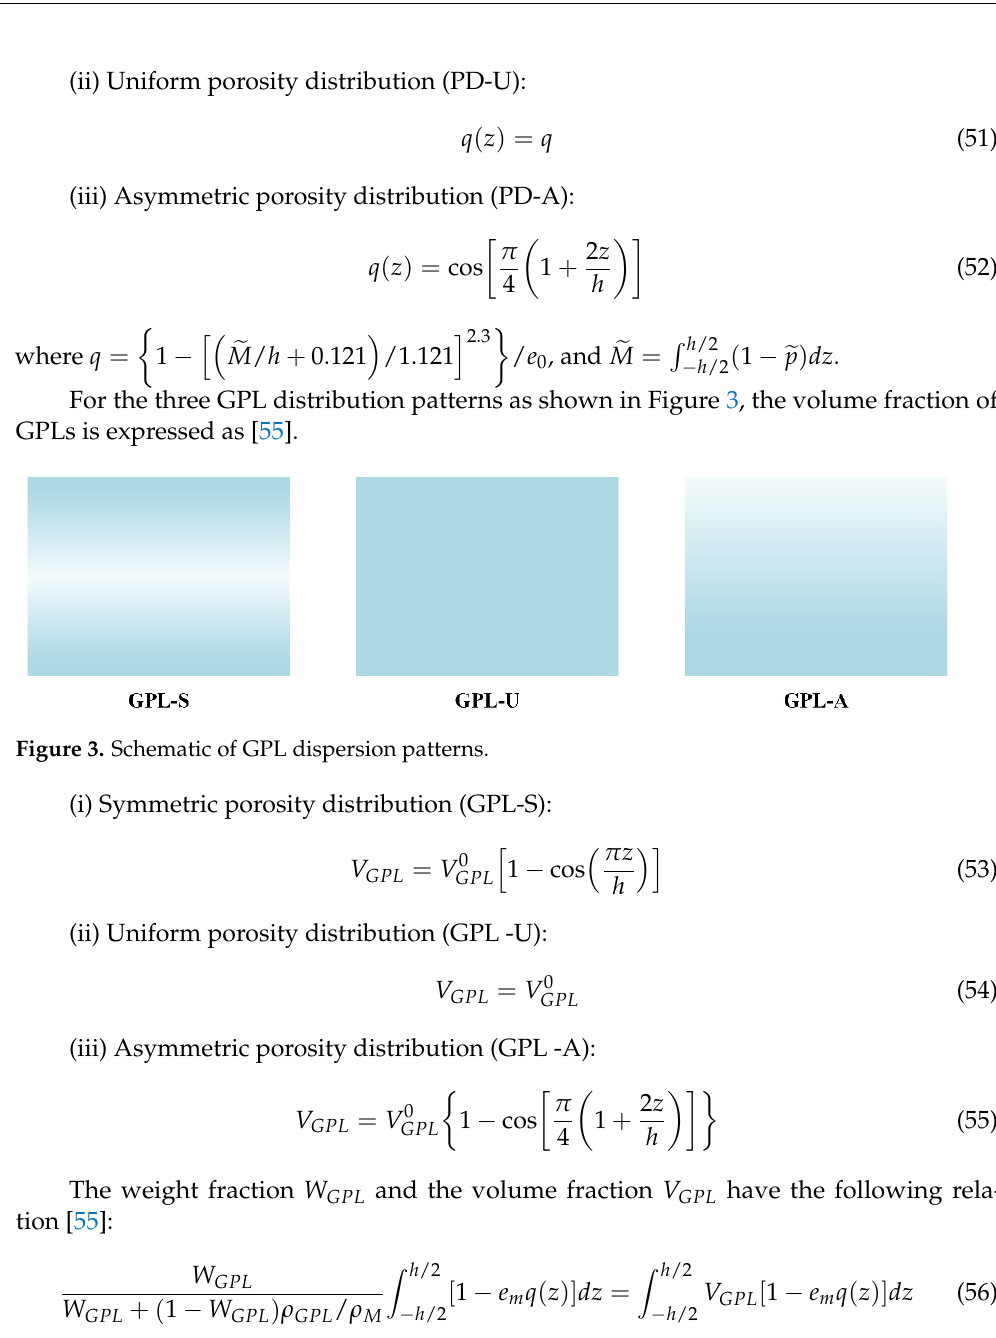
Table 1. Critical pressure (Psi) of homogeneous isotropic ring-stiffened cylindrical shells.